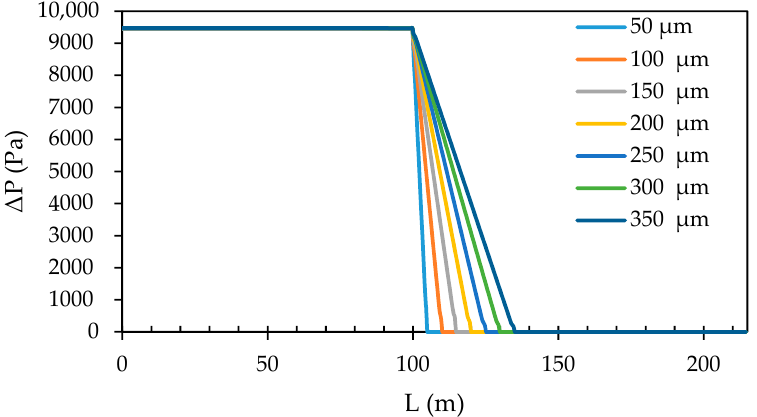
Figure 14. Development of the pressure profile through the spacer zone, the membrane zone and the outflow zone at different membrane thickness values.